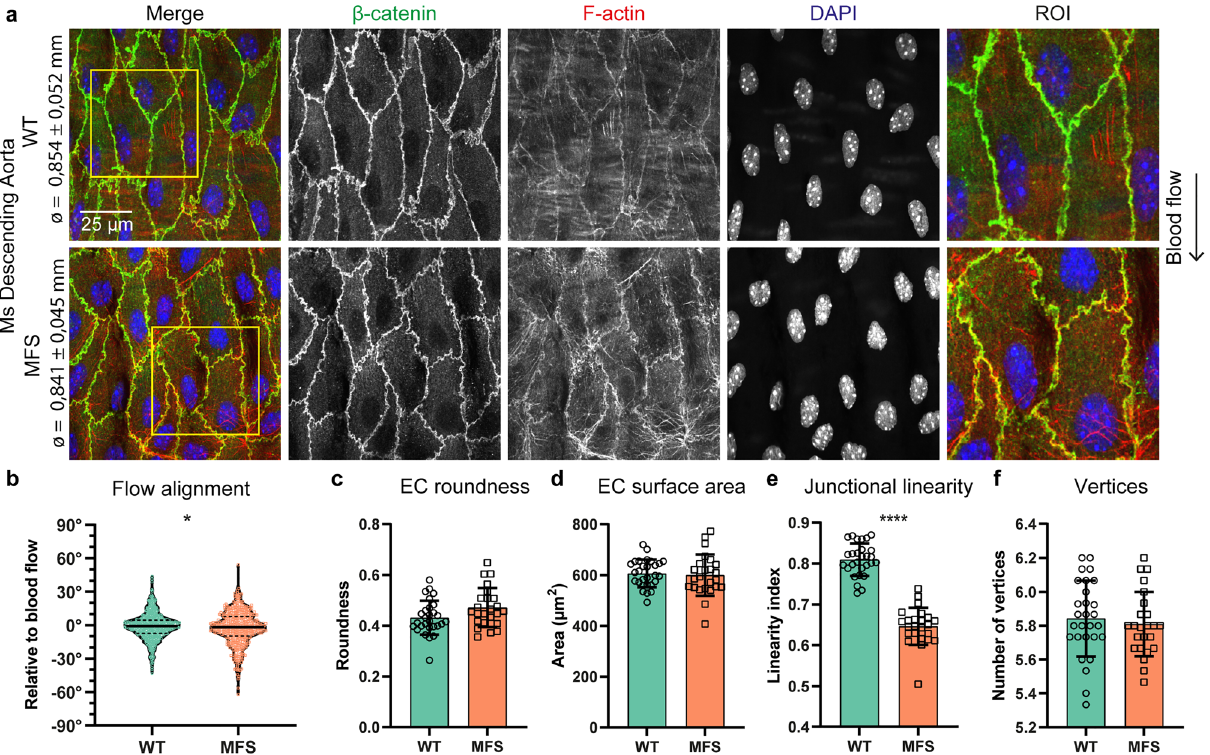
Figure 2. Reduced flow alignment and junctional linearity in ECs of the non-dilated thoracic descending aorta. ( a ) Representative en face IF confocal images showing β-catenin (green), F-actin (red), and DAPI (blue) of thoracic descending aorta from 9 weeks old Fbn1 C1041G/+ MFS mice and their WT littermates indicated with aortic diameter. EC junctional shape is highlighted in the ROI, and direction of blood flow is indicated with an arrow. Scale bar: 25 μm. ( b ) Violin plot showing quantification of EC alignment normalized to the direction of flow. Data distribution was analyzed by Kolmogorov–Smirnov test, * indicates p < 0.05. ( c – f ) Bar plots of EC morphology parameters in the ascending aorta from 9 weeks old Fbn1 C1041G/+ MFS mice and WT littermates. All data are represented as mean ± SD with indicated datapoints for WT (N = 7; M/F = 3/4) n = 28 images (total 420 ECs) and MFS (N = 6; M/F = 2/4) n = 24 images (total 360 ECs). **** p < 0.0001 analyzed by students